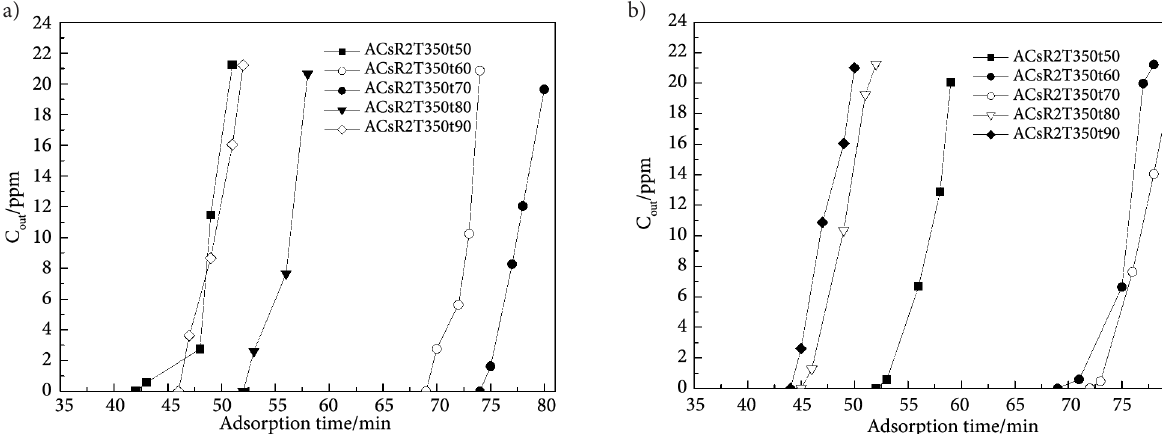
Figure 3. Adsorption time curves of different activation time (a: ACs;